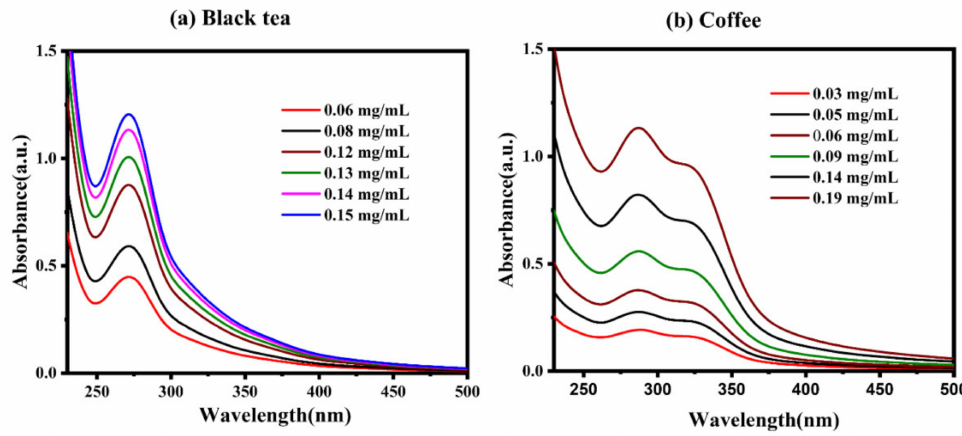
Figure 1. ( a ) UV-Vis spectra for calibration curve construction of ( a ) black tea extract in a range of 0.06–0.15 mg/mL. ( b ) coffee extract in a range of 0.03–0.19 mg/mL.